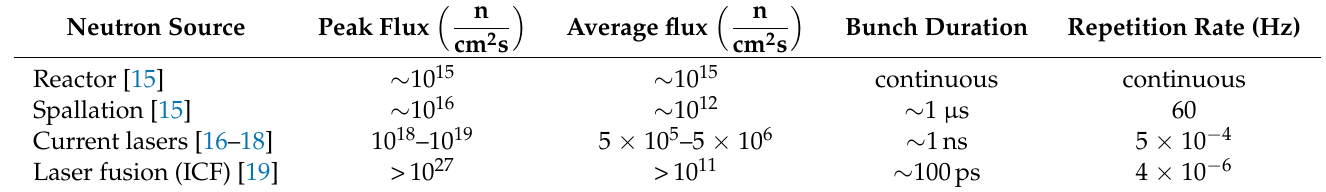
Table 1. Overview of the characteristics of presently available neutron sources. (adapted from